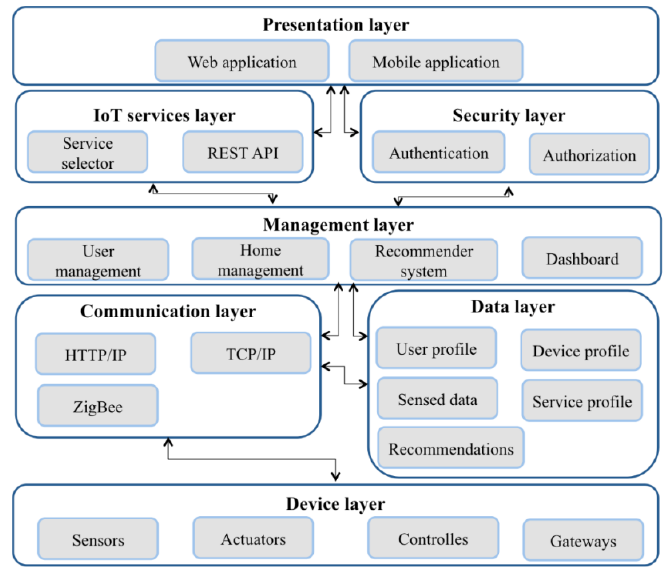
Figure 1. Architecture of HEMS-IoT.